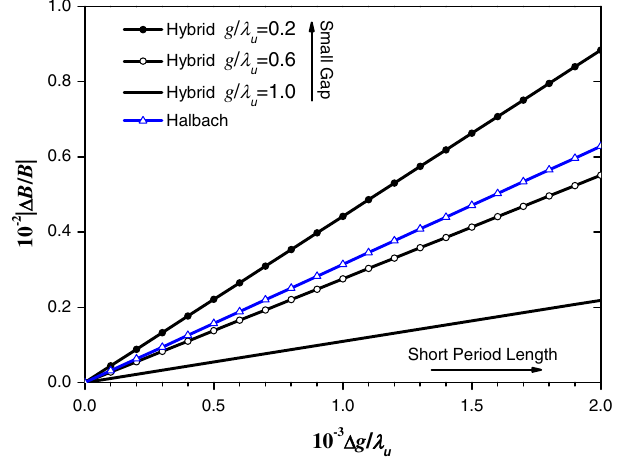
FIG. 5. Dependence of the relative field error on gap errors in the CPMU (TPS-CU15). For comparison, the dependence in a Halbach type is also shown.